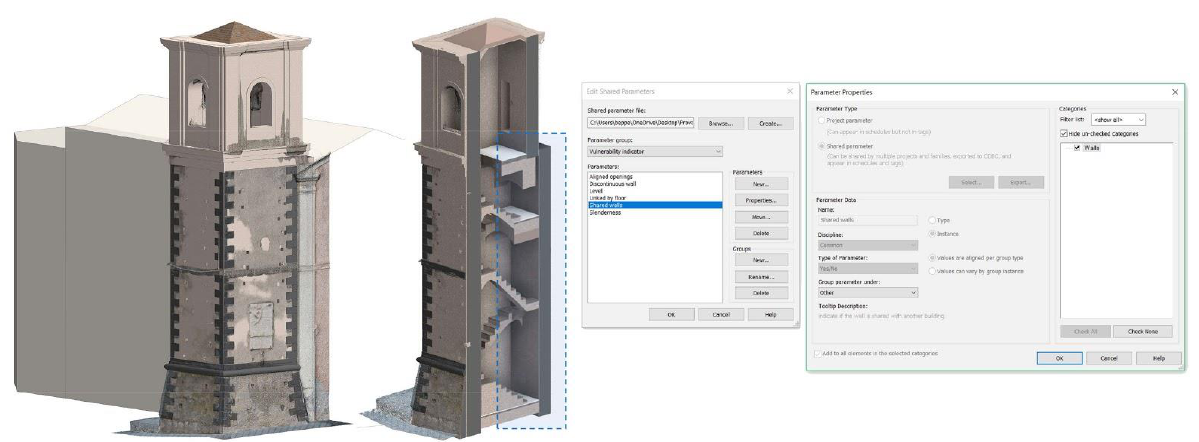
Figure 5. The HBIM of San Giuseppe bell tower superimposed on the point cloud. The shared parameters group and the parameter properties (took as an example the “shared wall” parameter) are shown on the